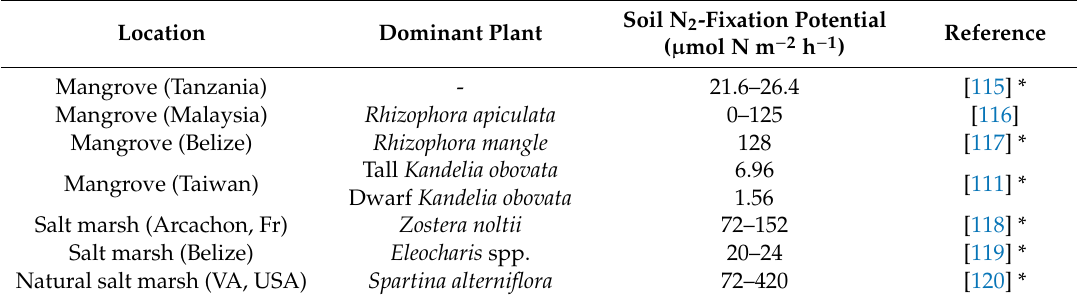
Table 3. Nitrogenase activity among different coastal ecosystems.